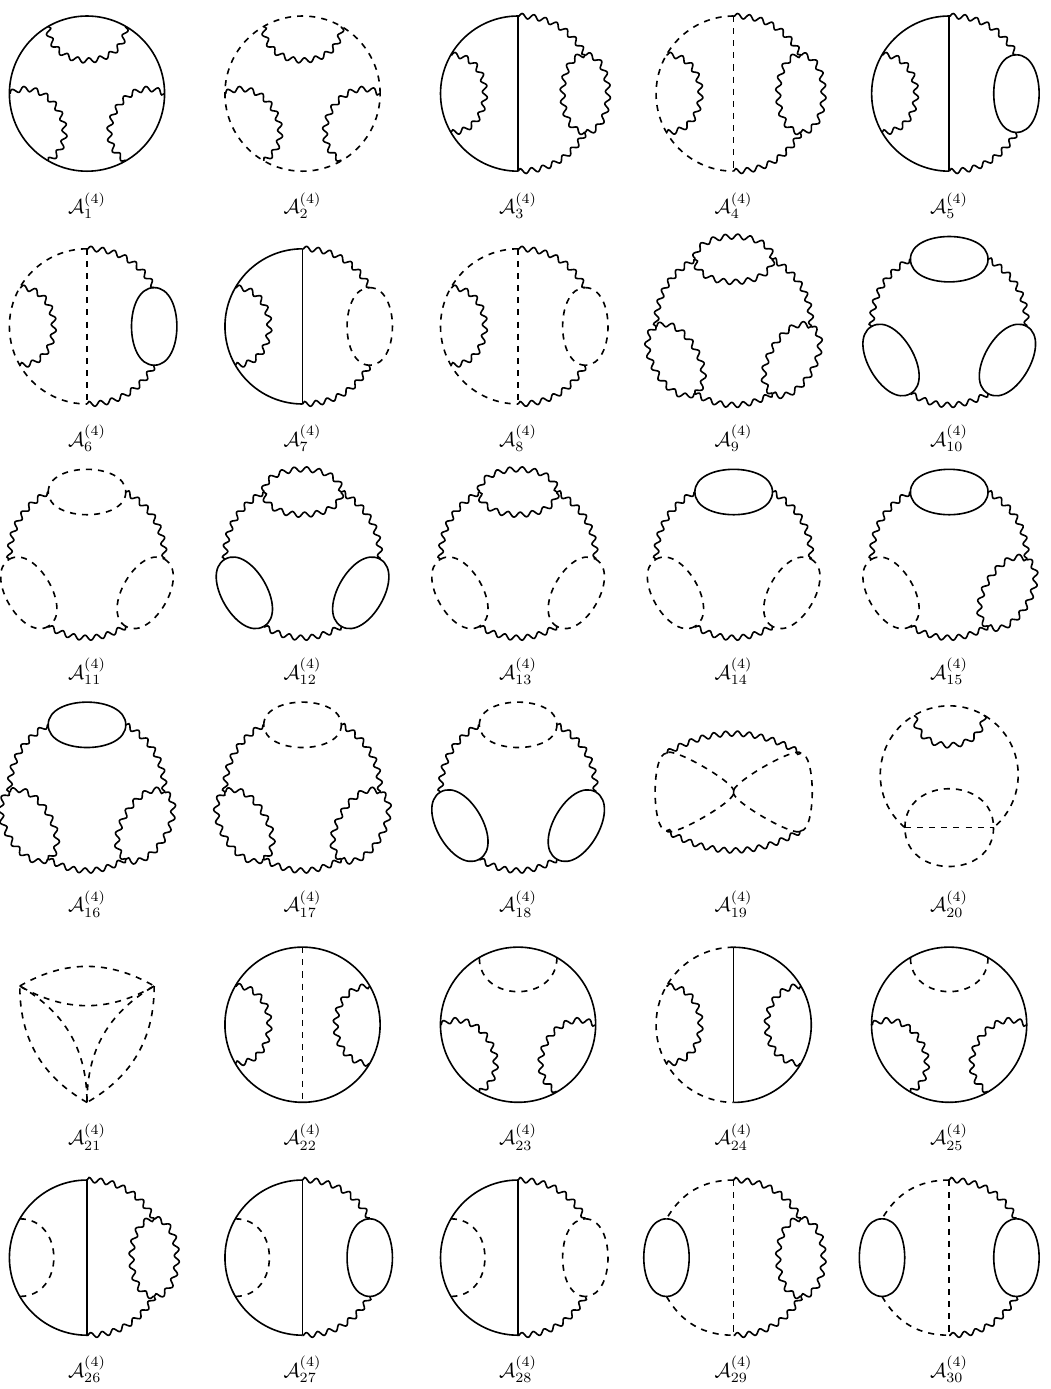
Figure 10 . Graph representation of the (cid:12)rst 30 contributions to the 4-loop A -function.